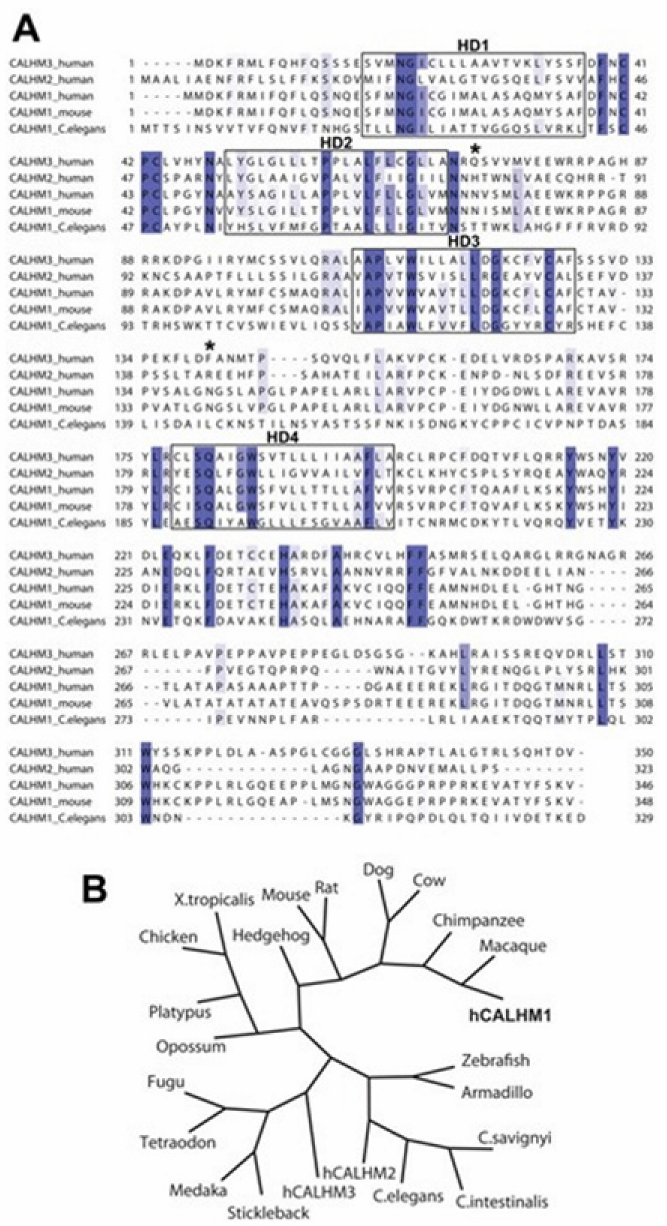
Figure 9. The alignment and the phylogeny of the CALHM1. ( A ) the alignment of the sequence of the human CALHM3, CALHM2, and CALHM1, and of the murine and the C. elegans CALHM1. The conserved sequences have been highlighted with blue and the sequence conservation has been mapped with a gradient of color, the darkest color is used to represent the sequences having absolute level of identity and the lighter colors to represent the sequences having weaker level conservation. The boxes are to denote the hydrophobic domains 1–4 (HD1–4). Stars, the predicted sites of N- glycosylation on the human CALHM1. ( B ) the phylogenetic tree that include the human CALHM1, denoted as ‘hCALHM1 (cid:48)